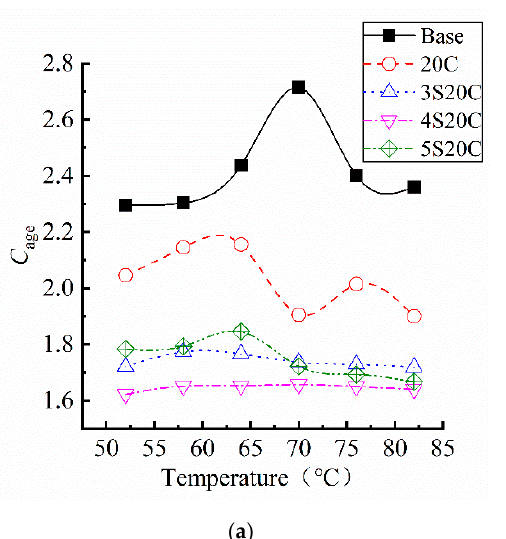
Figure 7. Brookfield viscosity aging index ( V age ) with different modifier content.